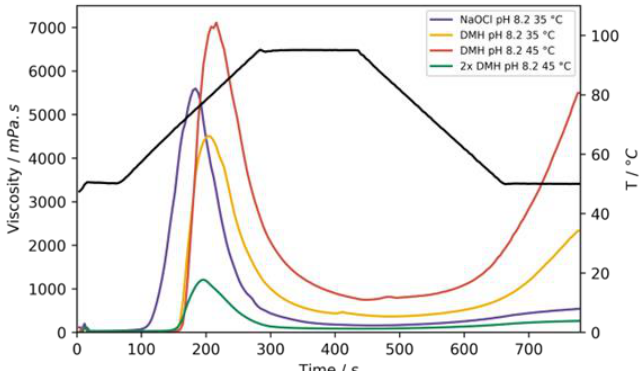
Figure 4. RVA pasting curves (30 wt% in water) of starches oxidized with NaOCl or DMH at pH 8.2 using 8.5 mol% (purple, red yellow) or 17 mol% -OCl (green).